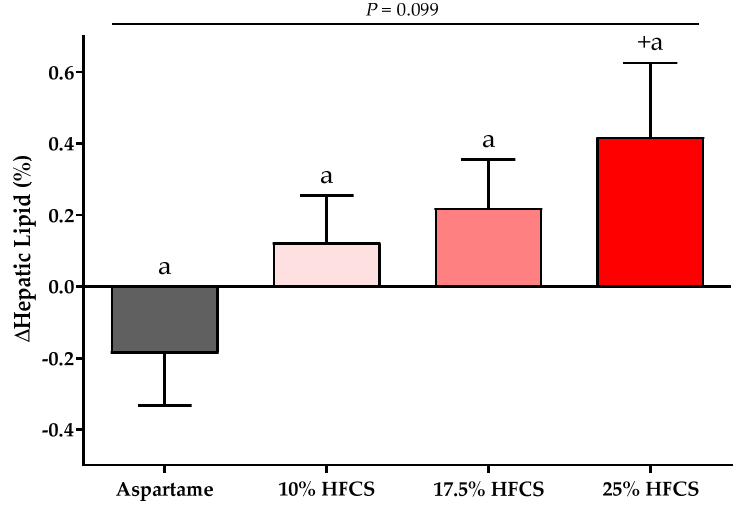
Figure 2. Changes in hepatic lipid content: Mean ± SEM of the absolute change (intervention − baseline) of hepatic lipid content in participants consuming 0 ( n = 20), 10 ( n = 16), 17.5 ( n = 16), or 25% ( n = 23) HFCS-sweetened beverages for two weeks. p = the effect of HFCS group, two-factor (HFCS group, sex) ANCOVA with adjustment for MSRF and outcome at baseline; + p < 0.05, LS mean different from zero.